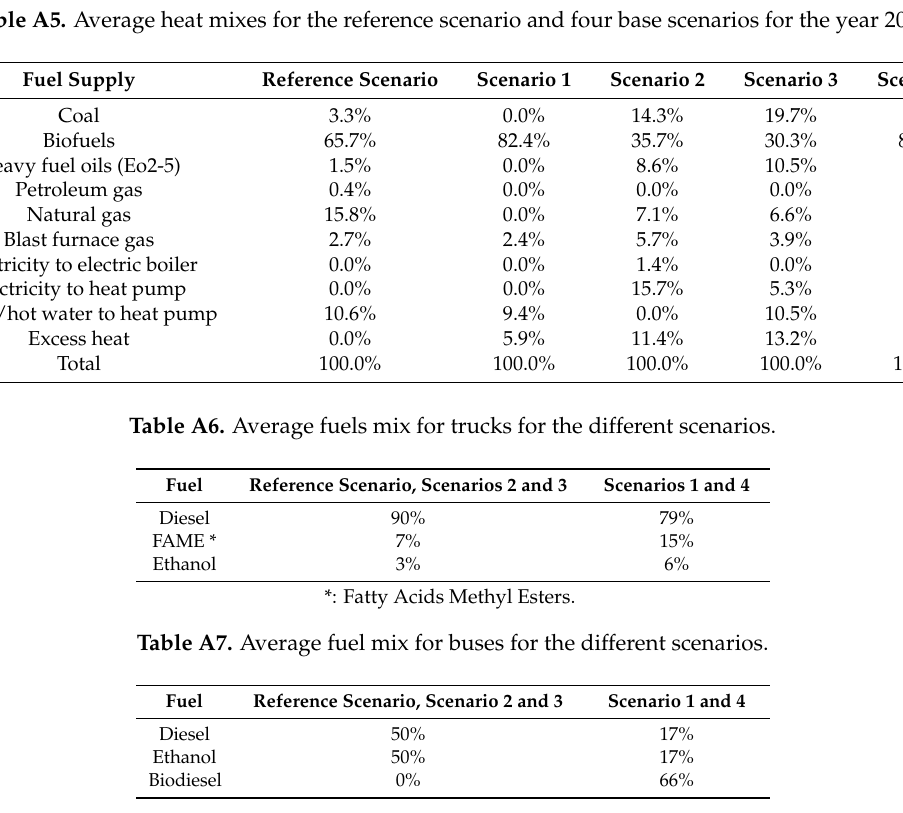
Table A8. Average fuel mix for cars for the different scenarios.